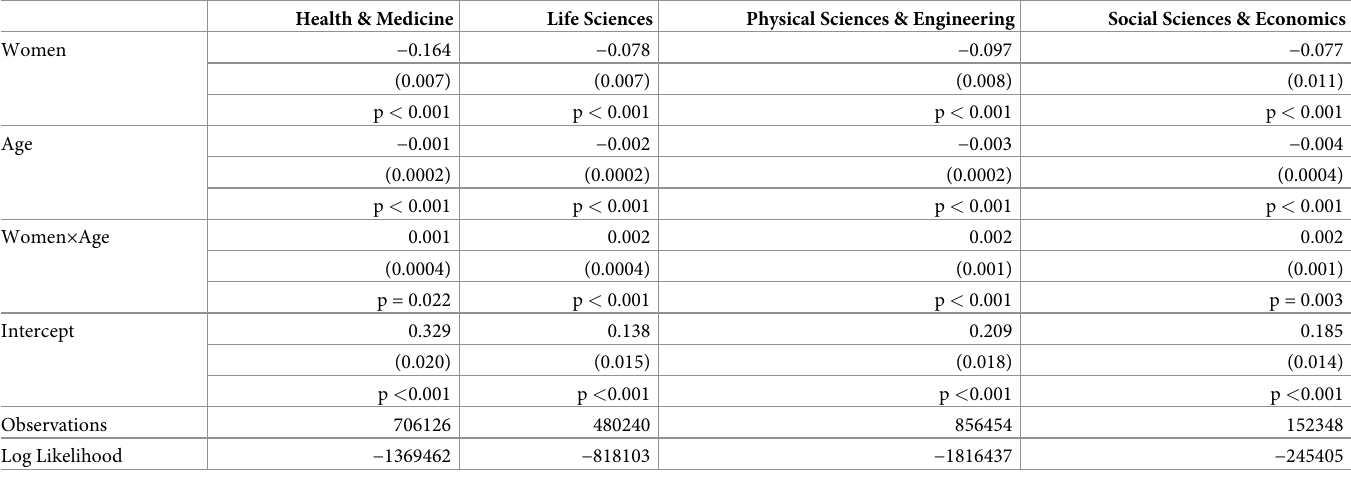
Table 2. Mixed effects models predicting February-May 2020 changes in the number of submissions per area of